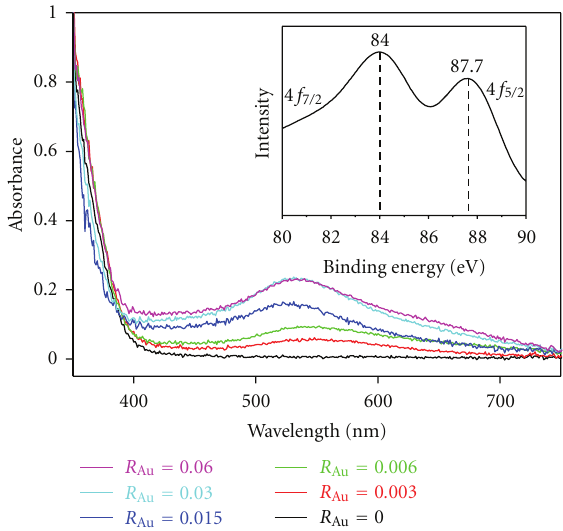
Figure 4: UV-Vis absorbance spectra of the Au-TiO 2 composite powders prepared with di ff erent R Au and (inset) high-resolution XPS spectrum of Au 4f of the R Au -0.060 sample.